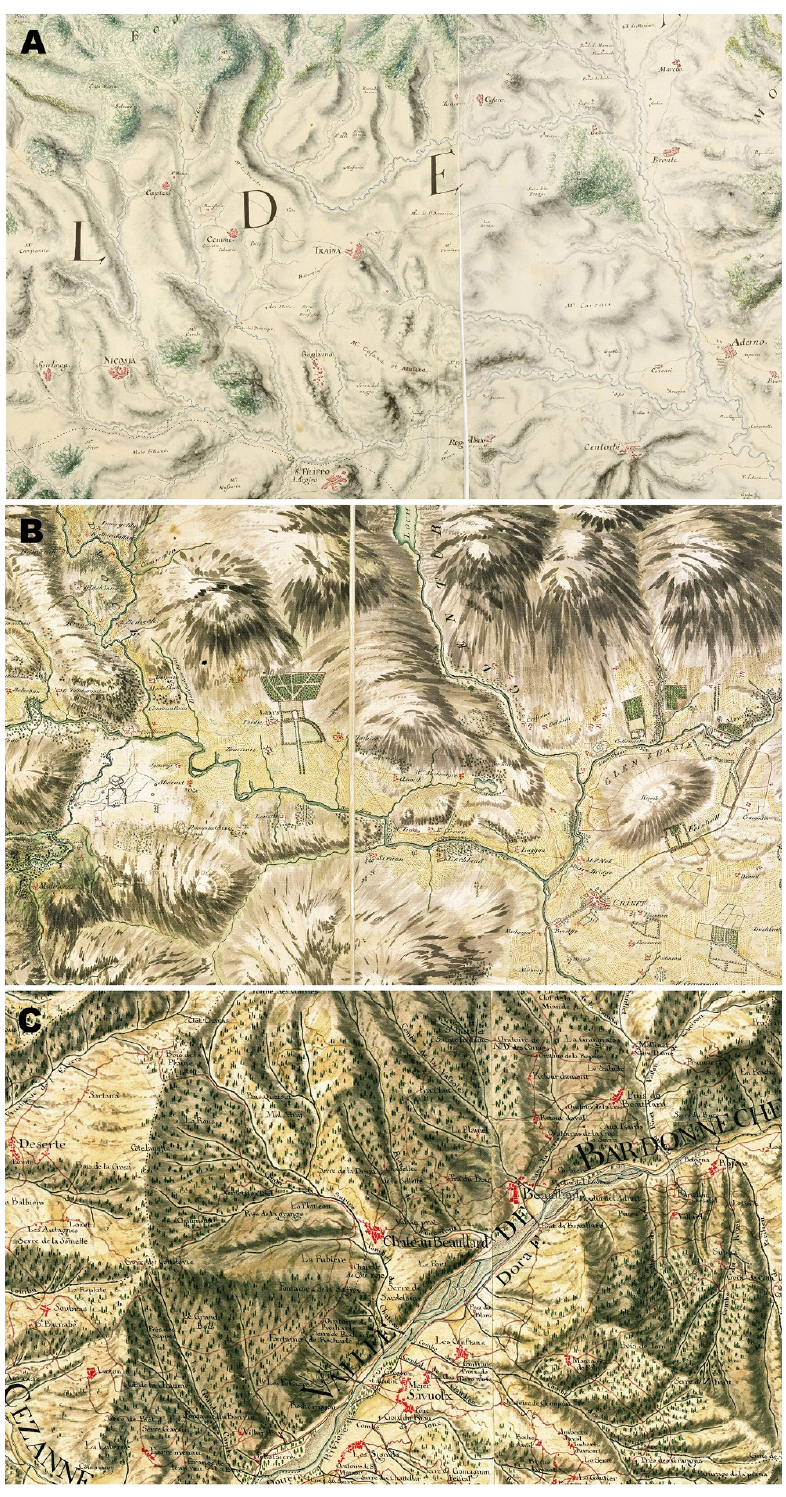
Figure 1. Map fragments with reduction from the originals by approximately 70%: ( A ): Nova et accurata Siciliae Regionum, Schmettausche Karte von Sizilien (1722), ca. 1:80.000; Vienna, Österreichische Nationalbibliothek; Schmettau: Sizilien, ÖNB/KAR: AB141, E19.585-D: 12; ( B ): Military Survey of Scotland—Highlands, ca. 1:36.000; 1747–1752. London, British Library. K.Top: Maps. CC.5a441/16-3f BL; ( C ): Valle di Susa: CARTA TOPOGRAFICA in misura, delle Valli di Cezana, e Bardoneche…, (1764), ca. 1:19.000; Turin, Archivio di Stato; Cartella 7, Susa.